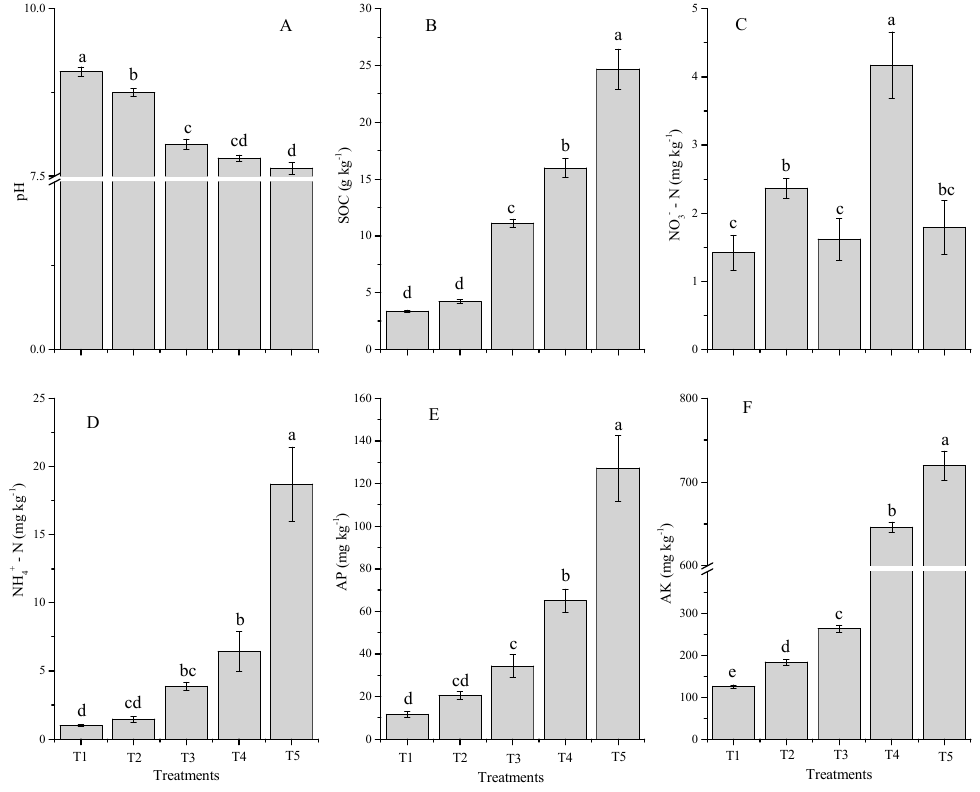
Figure 4. Influences of co-application of TW and chemical fertilizers soil chemical properties, soil pH ( A ), SOC ( B ), NO 3 − -N ( C ), NH 4+ -N ( D ), AP ( E ) and AK ( F ) after wheat harvested. Without amendment (T1), chemical fertilizers (T2), TW 2.5% + F (T3), TW 5% + F (T4) and TW 10% + F (T5). The data showed the mean of three replications, and error bars are standard deviations. Different letters indicate there were significant differences ( p < 0.05) in the LSD means comparisons between the treatments mean.